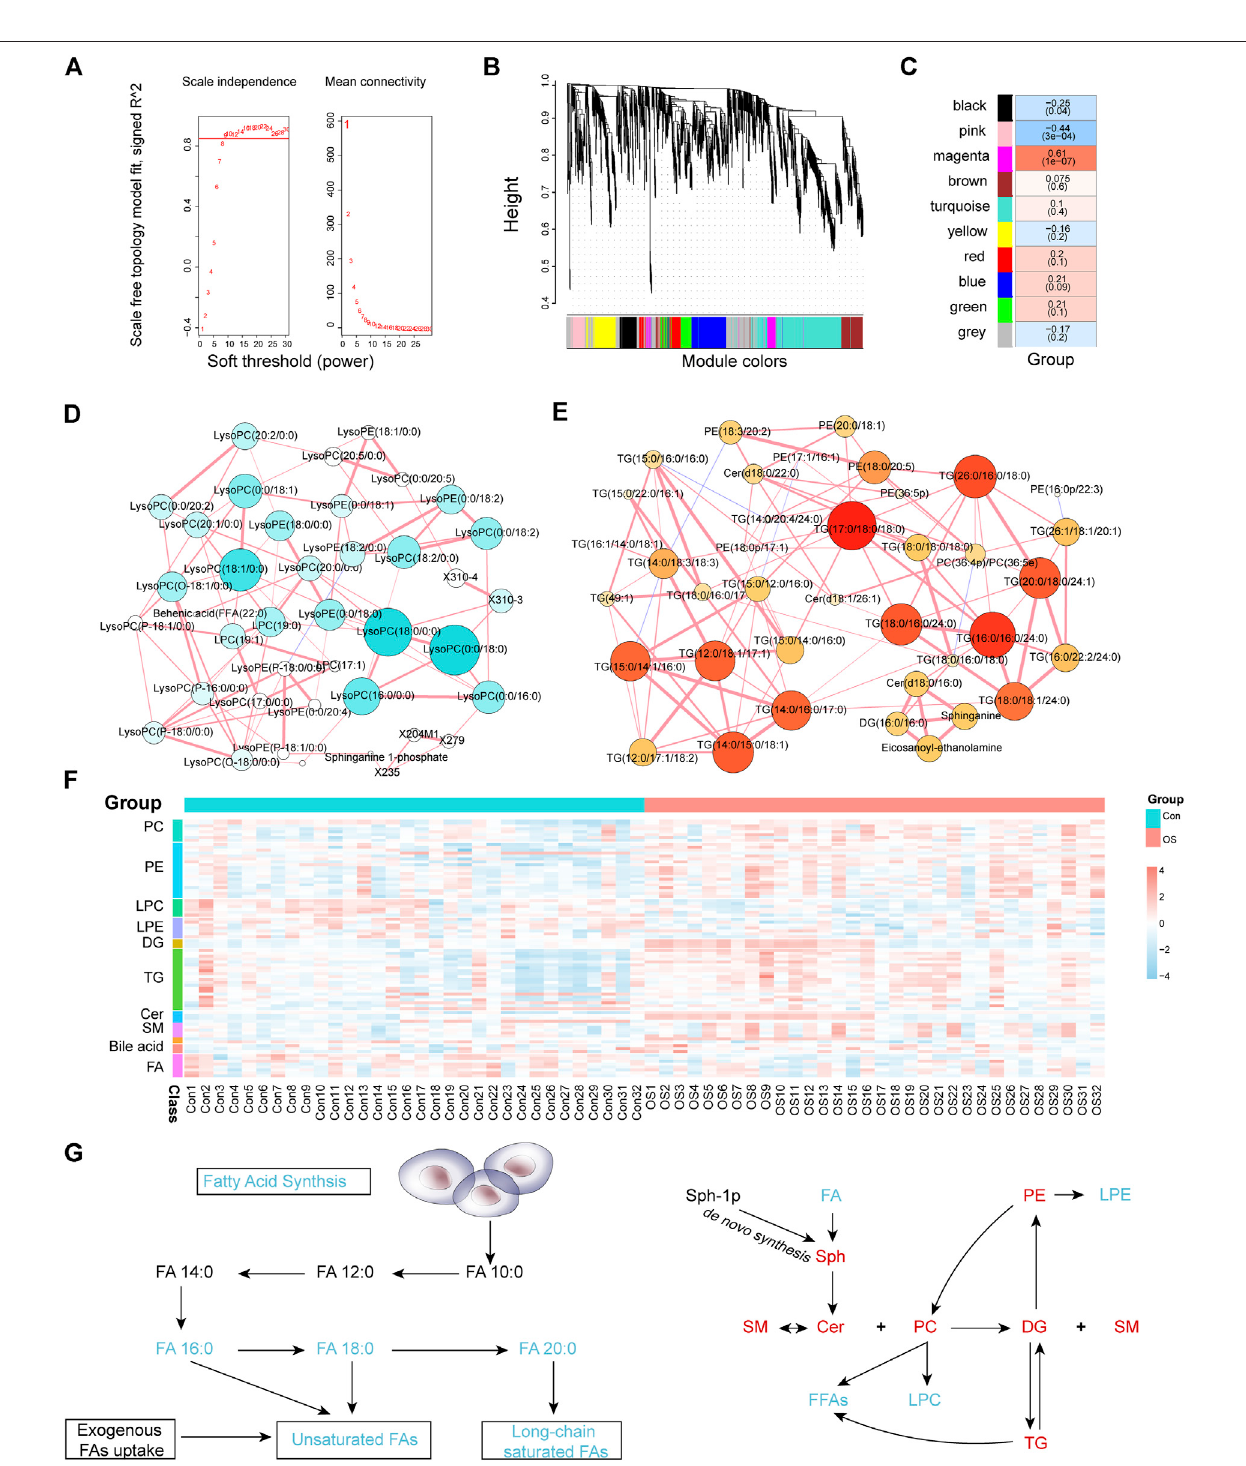
FIGURE3| Softthreshold selectionwasbasedonscale-freetopologyR2andmeanconnectivity (A) .Amoduleclustertreewasusedtovisualizethedistributionof metabolites in each module (B) . The correlation coef fi cients and p -values between modules and osteoporosis (C) . The MMI networks of the pink (D) and magenta (E) modules. The correlation of MMI was based on debiased sparse partial correlation (DSPC). The heatmap of osteoporosis-related metabolites and lipids that were differentially expressed between the OS and Con groups (F) . Schematic plot of FA synthesis metabolism and the mutual transformation between subclasses of lipids (G) . Black text represents undetected metabolites, red text represents signi fi cantly enriched metabolites, and green text represents signi fi cantly depleted metabolites when the OS group is compared with the Con group.